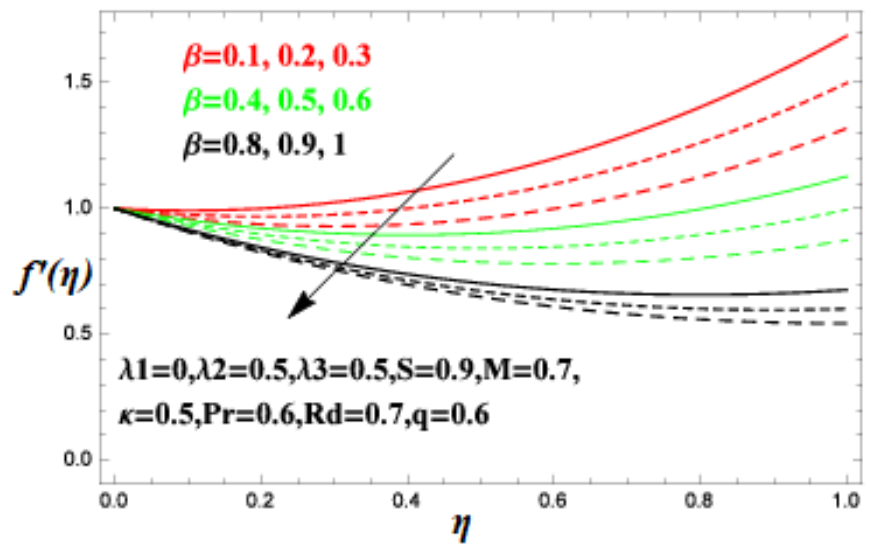
Figure 4. Fluctuations in velocity field f ( η ) for various values of β .